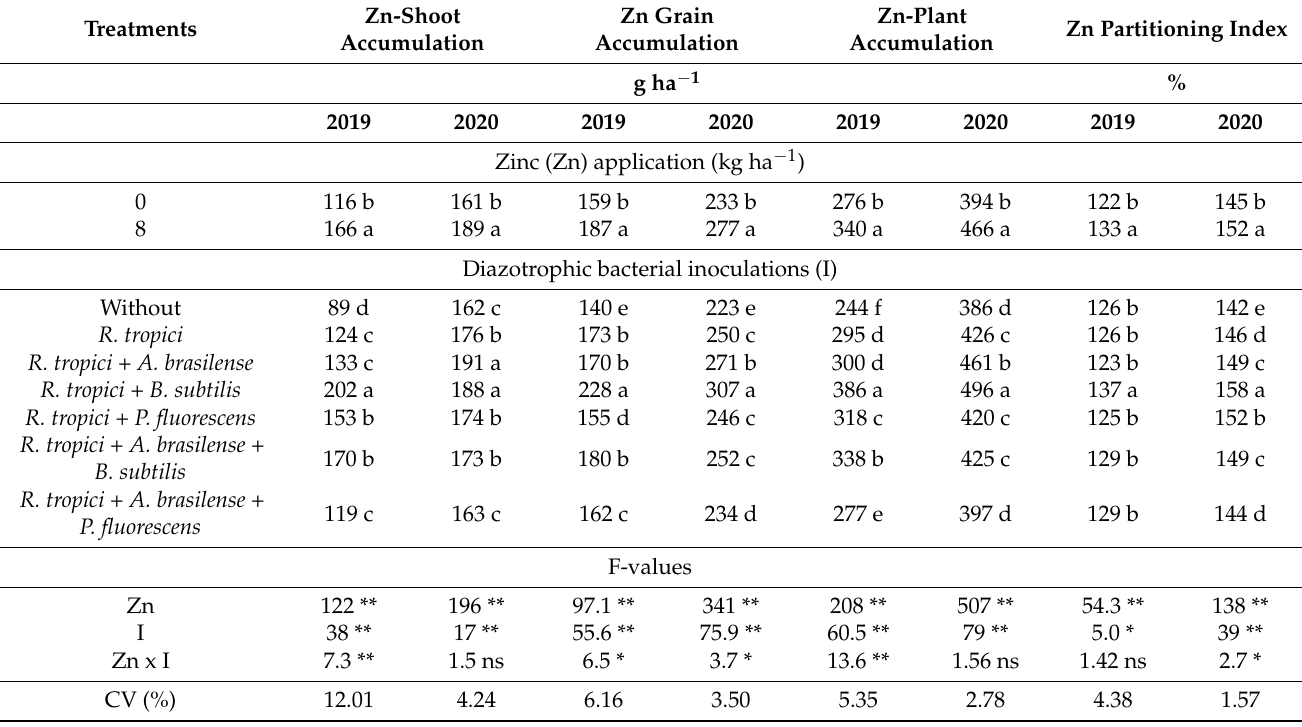
Table 3. Zinc accumulation in shoot, grain, and plant (straw + grain), and Zn partitioning index of common bean,